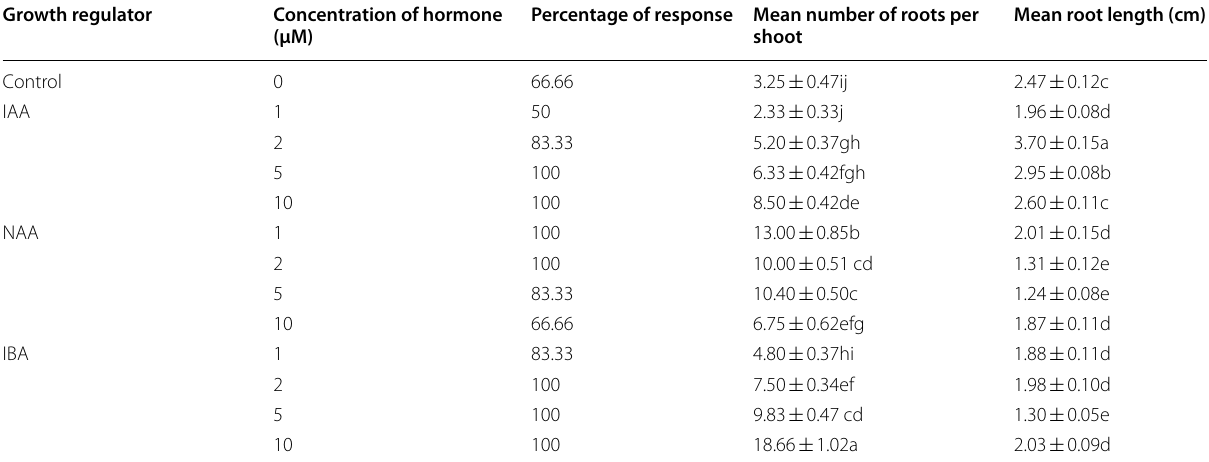
Table 2 Influence of auxins supplemented to quarter strength of Murashige and Skoog medium on induction of roots from shoots of Andrographis producta